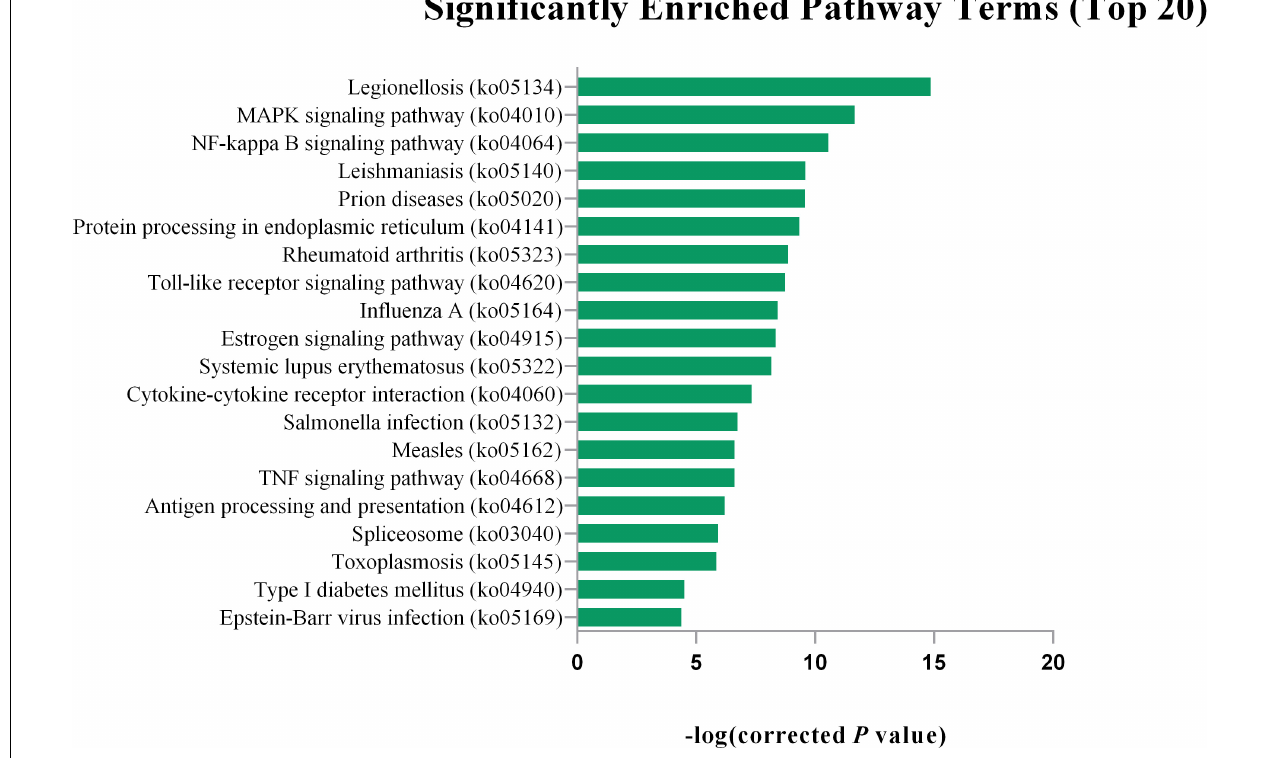
FIGURE 4 | The top 20 significantly enriched pathway terms for the target gene of DEGs. The top 20 KEGG pathway terms are Legionellosis (ko05134), MAPK signaling pathway (ko04010), NF-kappa B signaling pathway (ko04064), Leishmaniasis (ko05140), Prion diseases (ko05020), Protein processing in endoplasmic reticulum (ko04141), Rheumatoid arthritis (ko05323), Toll-like receptor signaling pathway (ko04620), Influenza A (ko05164), Estrogen signaling pathway (ko04915), Systemic lupus erythematosus (ko05322), Cytokine-cytokine receptor interaction (ko04060), Salmonella infection (ko05132), Measles (ko05162), TNF signaling pathway (ko04668), Antigen processing and presentation (ko04612), Spliceosome (ko03040)Toxoplasmosis (ko05145), Type I diabetes mellitus (ko04940), Epstein-Barr virus infection